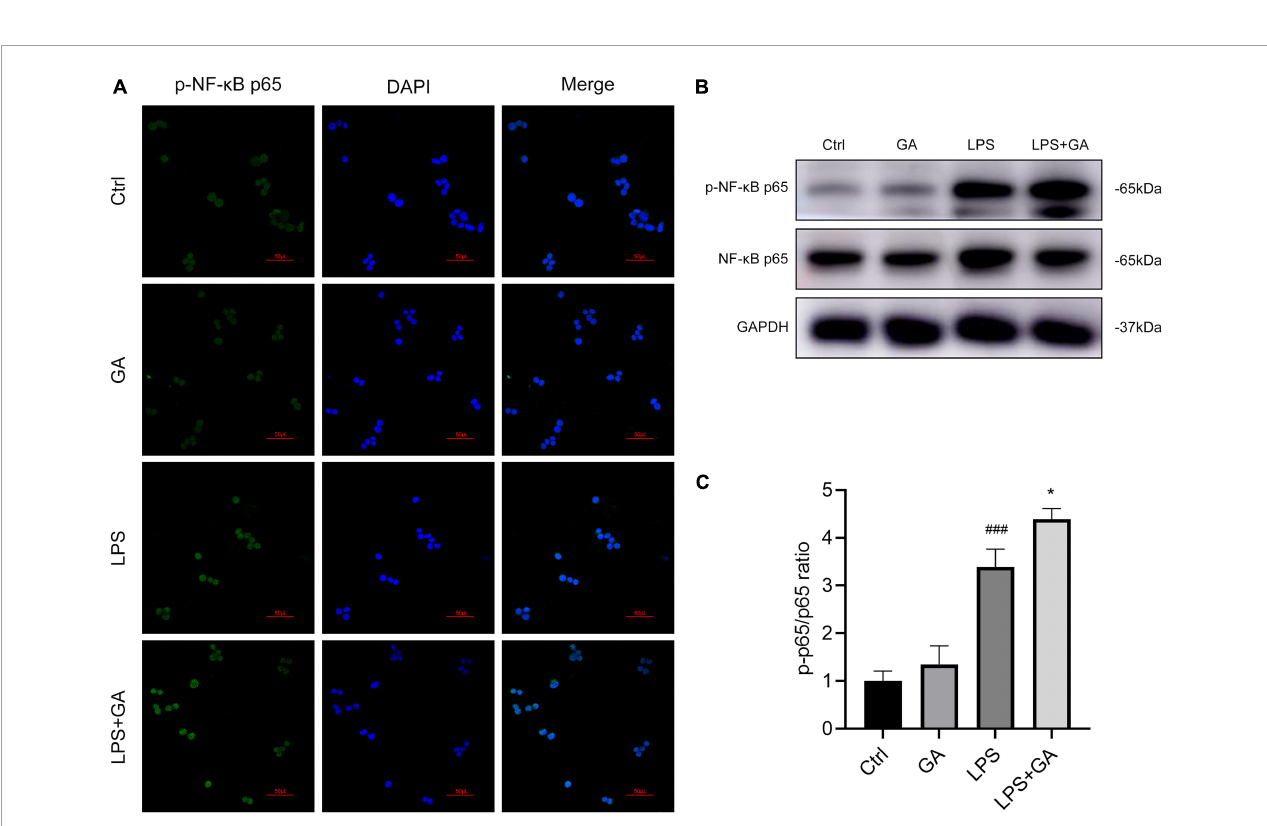
FIGURE5 Ginkgolic acid (GA) promotes NF- κ B p65 phosphorylation and nuclear translocation. (A) The changes of p-NF- κ B p65 nuclear translocation in RAW 264.7 cell after lipopolysaccharide (LPS) stimulation for 6 h were detected by immunofluorescence staining, treated with GA or vehicle ( n = 3). (B) Detection of the protein levels of p-NF- κ B p65 and NF- κ B p65 in RAW 264.7 cell after 6 h of LPS stimulation by western blot ( n = 3), and p-p65/p65 ratio was shown in (C) . ### P < 0.001 versus the Ctrl group; ∗ P < 0.05 versus the LPS